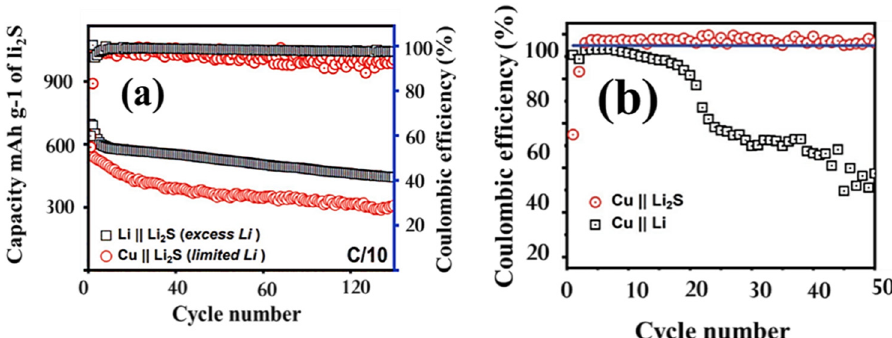
Figure 5. ( a ) Electrochemical performance of Li||Li 2 S half battery and anode-free Cu||Li 2 S battery, with a 4 mg · cm − 2 cathode. ( b ) Coulombic efficiencies of plating and stripping lithium on Cu foil from Li 2 S cathode and lithium-metal counter electrode (modified and adopted from [42]) .